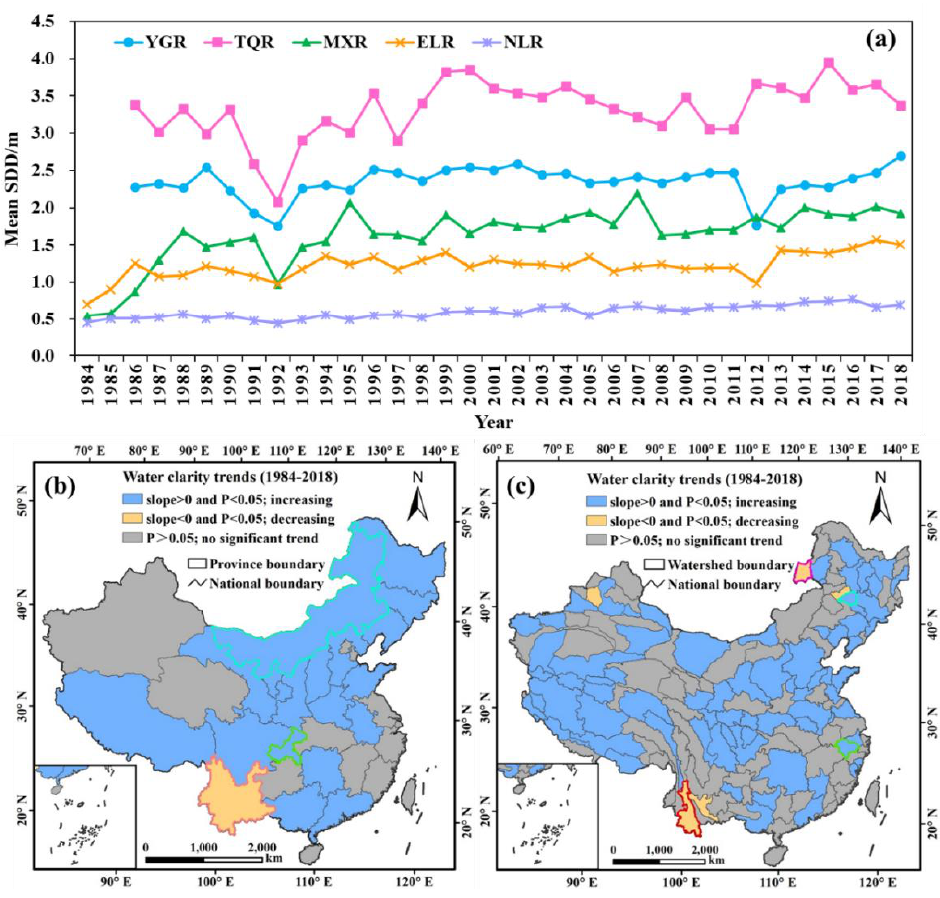
Figure 2. Interannual trends (1984 – 2018) in lakes SDD in five lake regions of China ( a ). Significant decreasing (slope < 0 and p < 0.05), significant increasing (slope > 0 and p < 0.05), and non-significant trends in SDD are presented for different provinces ( b ) and at the watershed scale ( c ). The green and purple boundaries depict, respectively, regions of maximum increasing and decreasing trends in SDD; the bright green and red boundaries represent, respectively, areas of minimum increasing and decreasing trends. The significance of slope is determined by t-test at the 5% significance level.